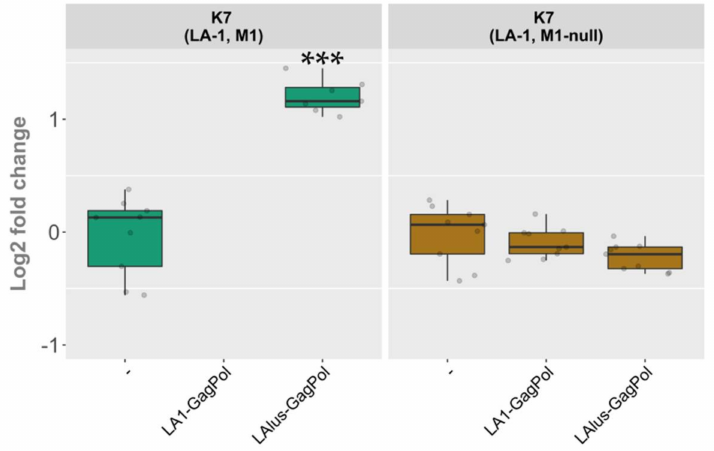
Figure 6. The role of M1 dsRNA in maintenance of the LA-1 virus following the overexpression of LA1-GagPol and LAlus-GagPol proteins. Relative change in the amount of LA dsRNA compared to control samples is depicted (-). Examined yeast strains are specified at the top; protein expression vectors are listed below. Gray dots correspond to individual samples. Statistical significance was evaluated using Student’s t -test. P values below 0.05 were considered statistically significant (*** p <